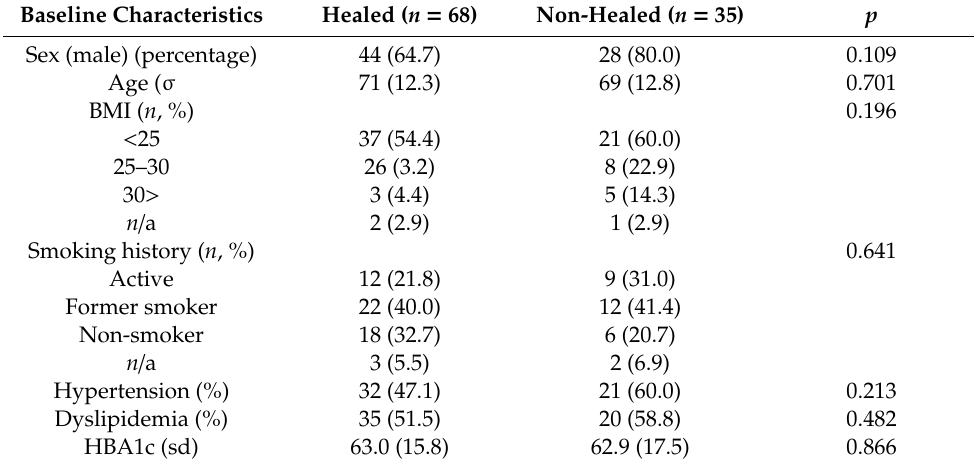
Table 1. Baseline characteristics.